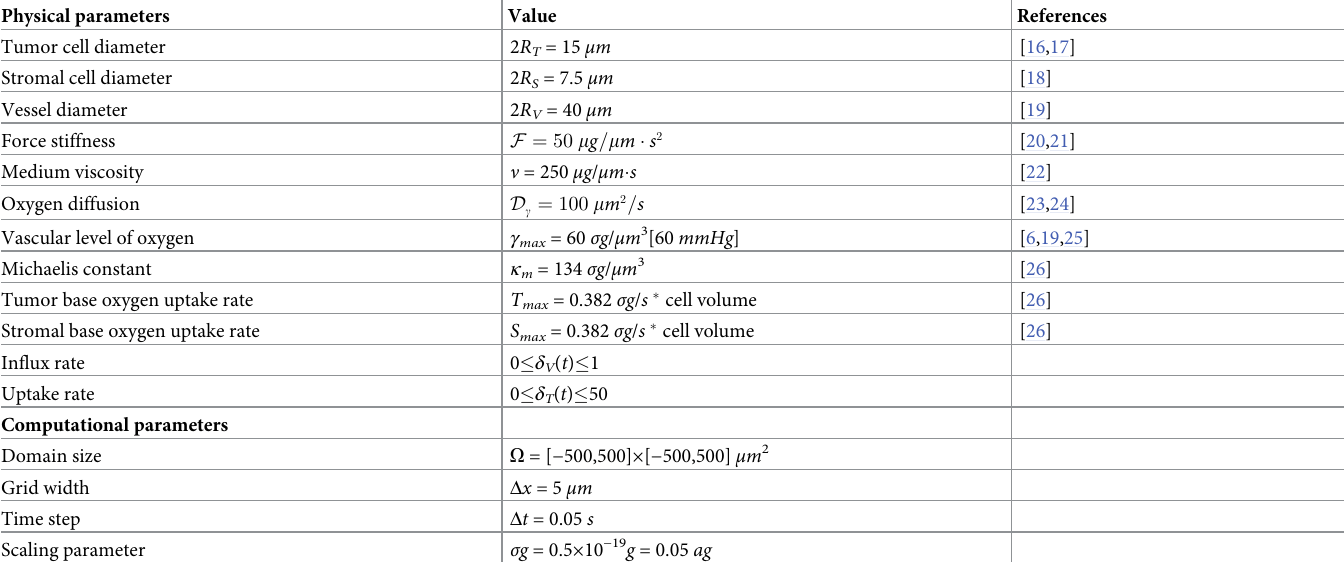
Table 1. Model physical and computational parameters. Physical